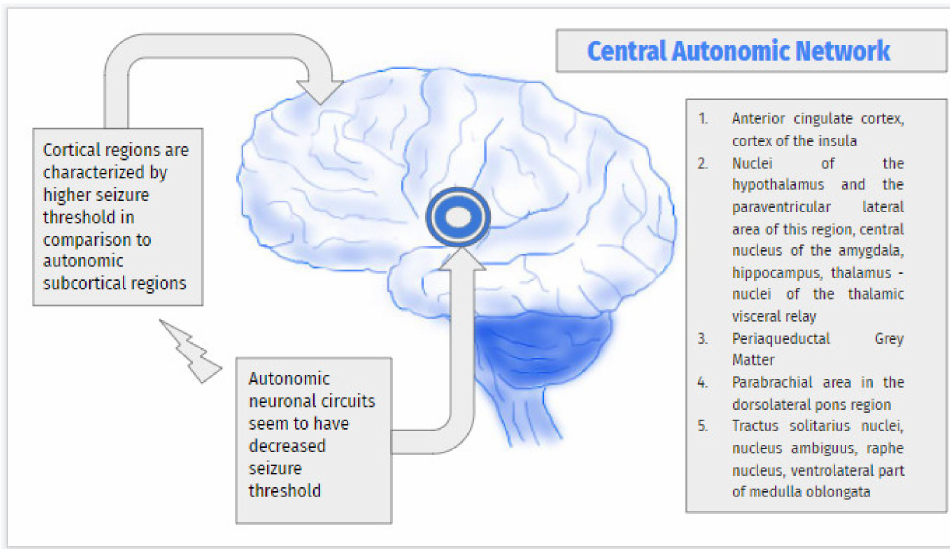
Figure 1. This figure shows the main components of the central autonomic network according to Benarroch and demonstrates that cortical regions are characterized by higher seizure thresholds in comparison to autonomic subcortical regions. A lower seizure threshold of subcortical components results in predominantly autonomic symptoms with further focal cortical seizures due to propagation of epileptiform